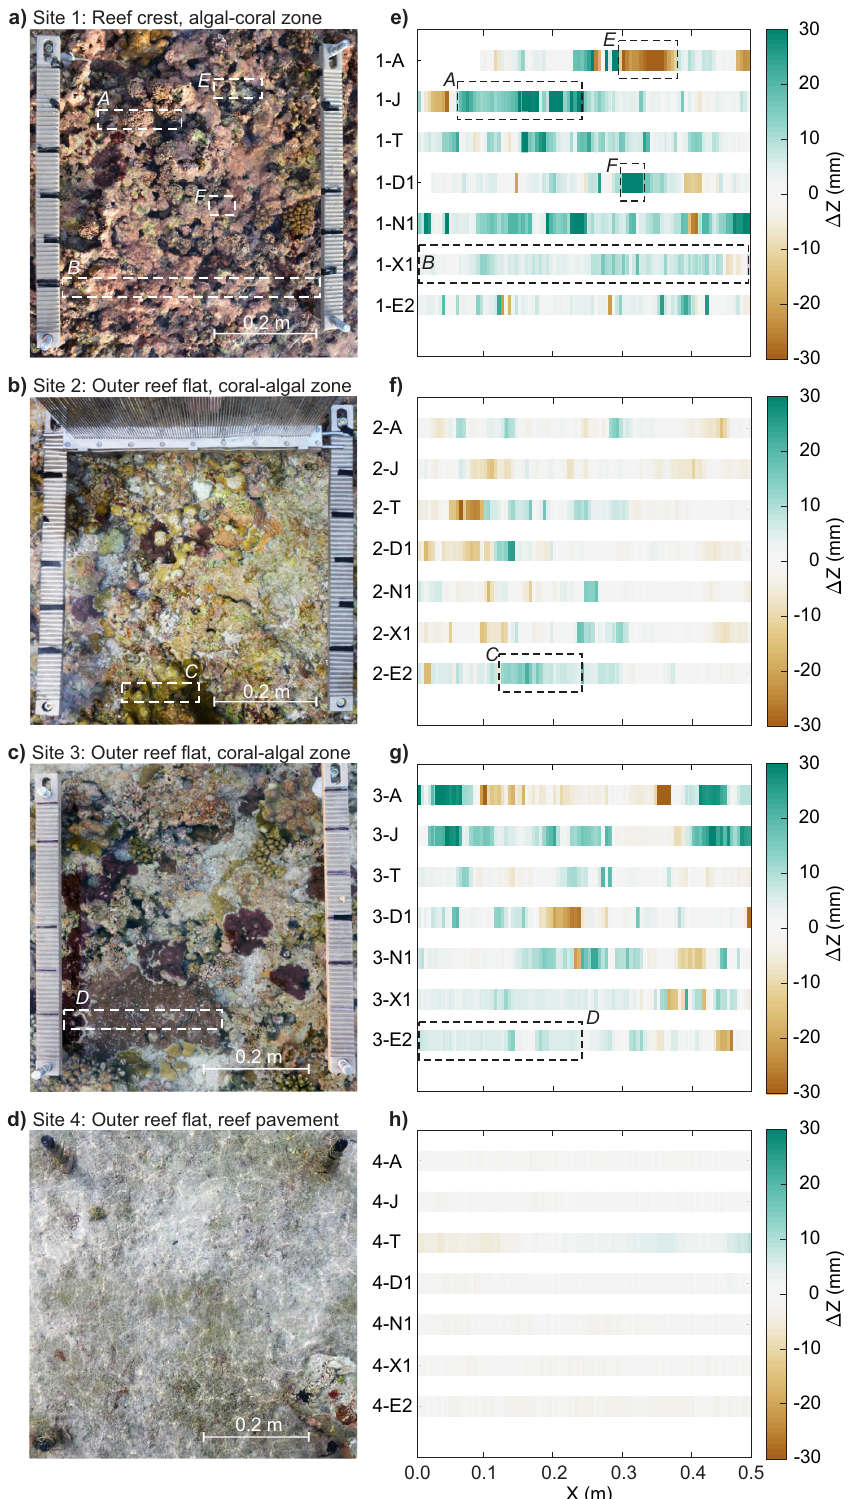
Fig. 2 Summary results of reef topographic change at CRAM sites, Keleihutta reef fl at, Maldives. a – d show images of each CRAM site. c – h Present corresponding summaries of topographic change across the two year experiemntal period, along each of 7 transect lines (A, J, T, D1, N1, X1, and E2). Individual transect lines presented in Supplementary Figs. 4 – 7. Inset boxes are areas highlighted in Fig. dataset (1,386 points) point-scale variation ranged from a maximum of 134.8 mm to − 92.0 mm in a single year.